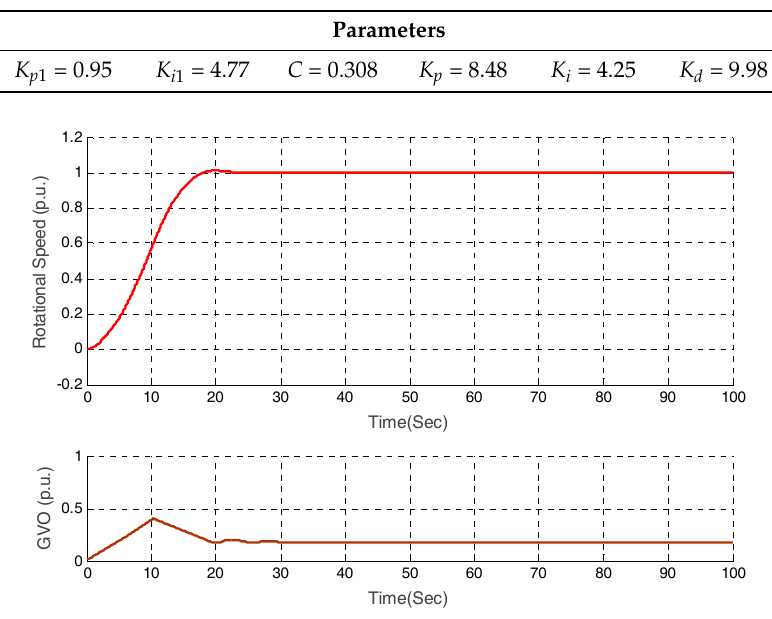
Figure 19. Comprehensive results of integrated start-up strategy.